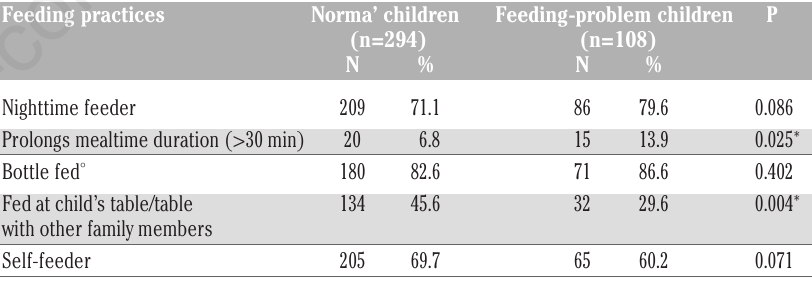
Table 5. Comparison of feeding methods between normal and feeding-problem children.